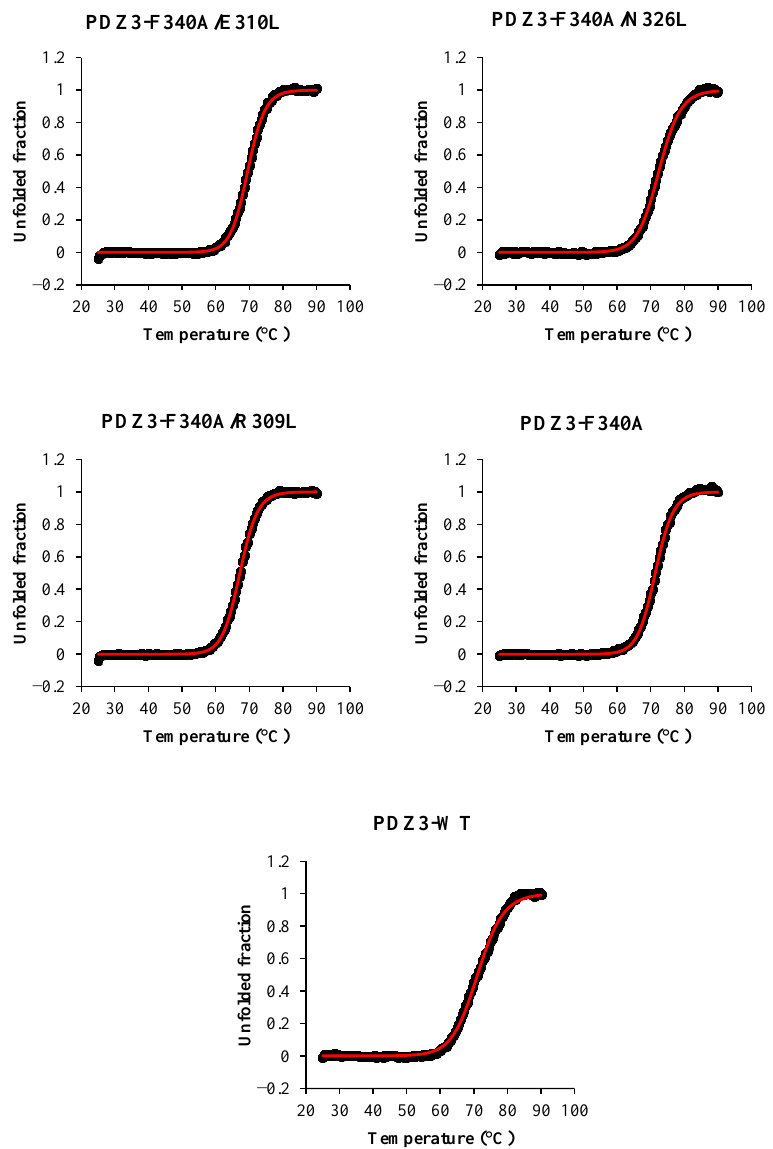
Figure 2. CD thermal denaturation curves of PDZ3 variants at 0.5 mg/mL and pH 7.5 at a scan rate of +1.0 ◦ C/min. The CD values were monitored at 220 nm. Black dots are the experimental data, and red lines are the fitting curves.